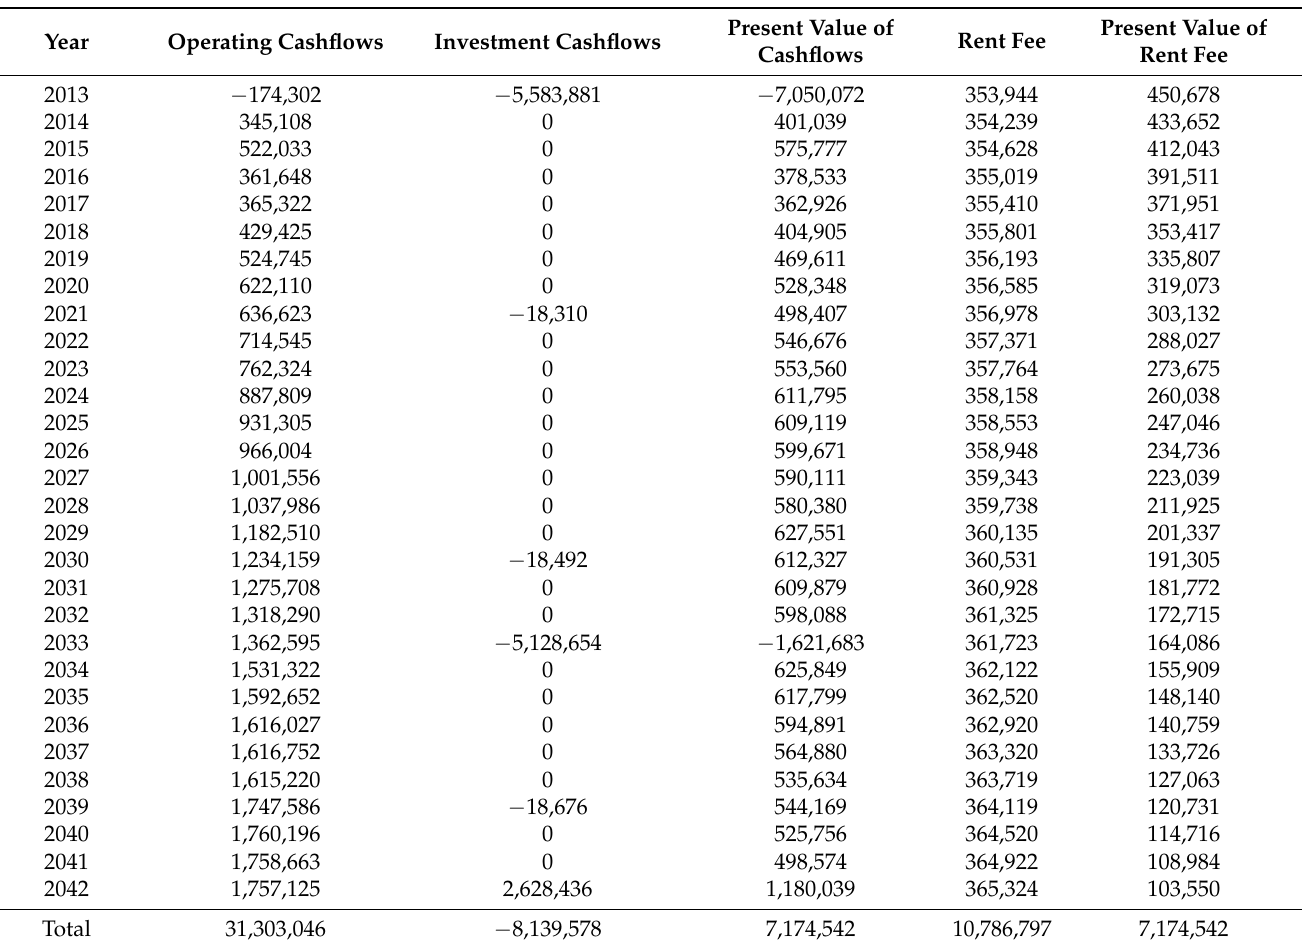
Table 10. Proper rent fee from the perspective of operating balance (units: U.S.